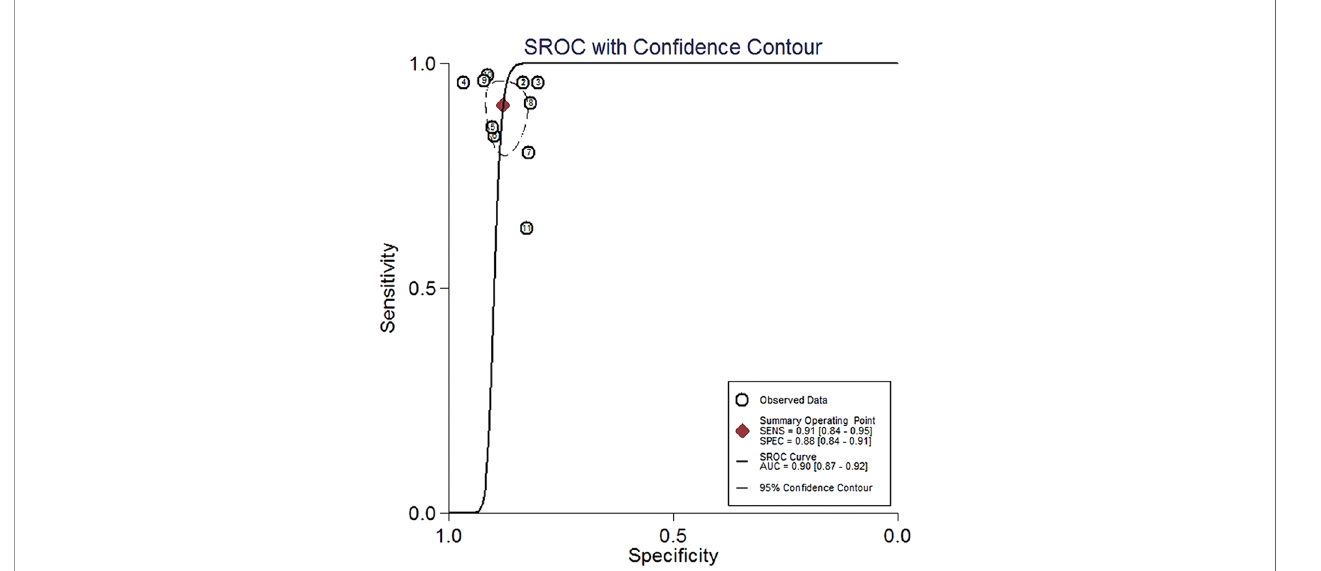
FIGURE 5 | Summary ROC curve with con fi dence around mean operating sensitivity and speci fi city point. ROC, receiver operator characteristic.